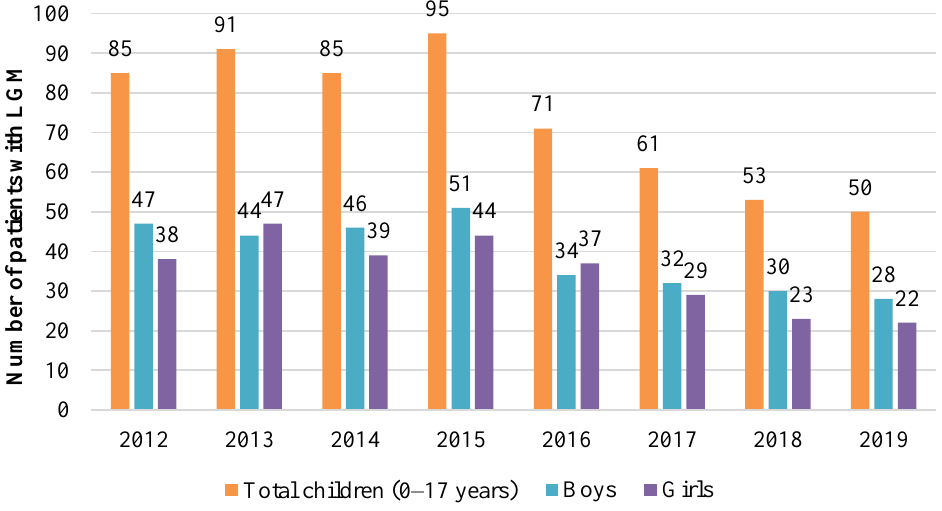
Fig. 5. Analysis of the dynamics of the incidence of child population of Ukraine on LGM during 2012–2019, including for 2019 – forecasting